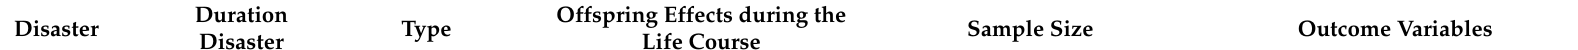
Table 2. An overview of the effects of prenatal maternal stress during the first 1000 days, due to exposure to